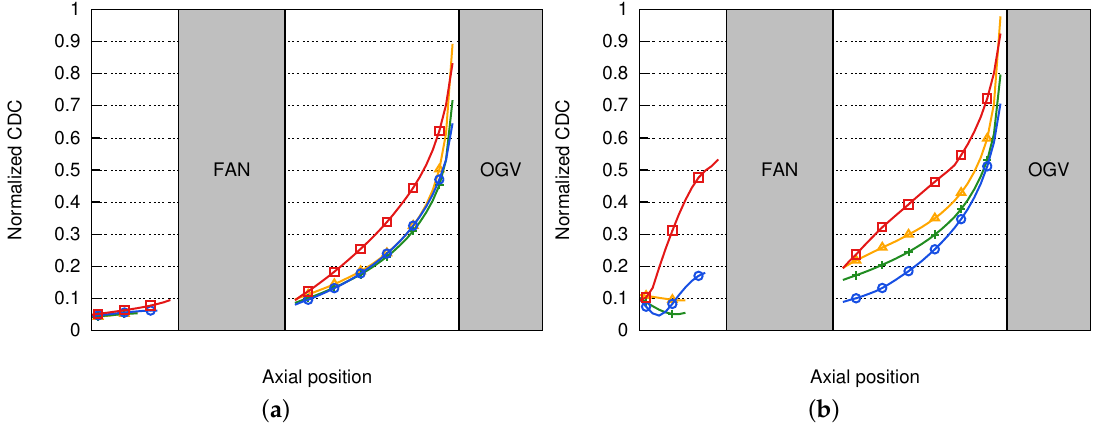
Figure 11. Evolution of the circumferential distortion coefficient (CDC) along the machine rotational axis at different channel heights for the axisymmetric air inlet ( a ) and the asymmetric one ( b ): the orange line marked with triangles, the green line marked with crosses, the blue line marked with circles and the red line marked with squares correspond to the CDC at 25%, 50%, 75% and 95% of channel height